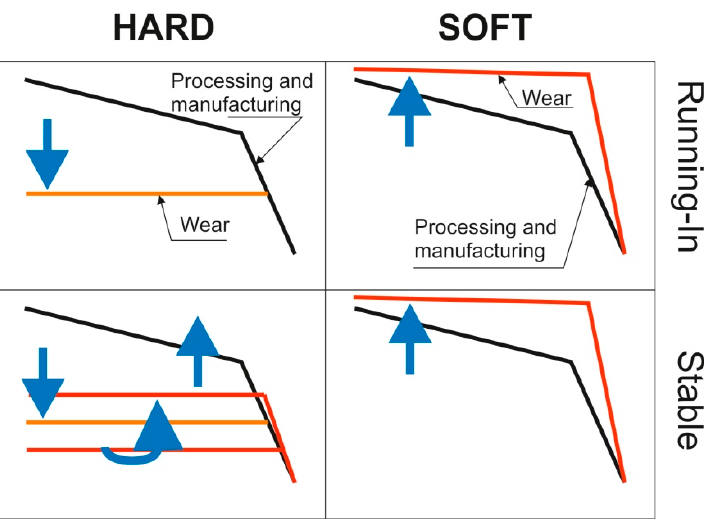
Figure 25. Modes of the evolution of random 2-process surface topography, adapted from